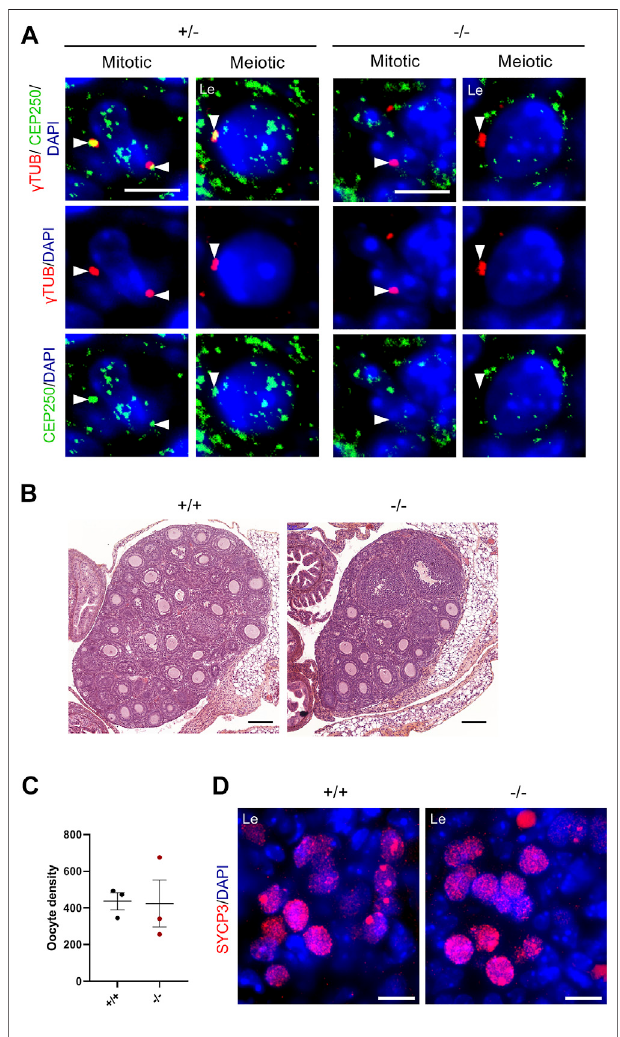
FIGURE 8 | Cep250 is not mandatory during oogenesis. (A) Immuno fl uorescence staining of γ -tubulin ( γ TUB, red) and CEP250 (green) in the control (+/ − ) and mutant ( − / − ) 15.5 days post-conception (dpc) foetal ovaries. DNA is stained with DAPI. White arrowheads indicate γ -tubulin- stained centrosomes. Note the absence of CEP250 in the centrosomes from mutant female germ cells. Le: Leptotene. Scale bar: 5 µm. (B) Hematoxylin/ eosin-stained sections of the control (+/+) and mutant ( − / − ) adult ovaries. Scale bar: 200 µm. (C) Quanti fi cation of the oocyte density in post-natal ovaries (5 – 10dpp).Mean ± SEM. (D) Immuno fl uorescence stainingofSYCP3 (red) in the control (+/ − ) and mutant ( − / − ) 15.5 days post-conception (dpc) foetal ovaries. Le: Leptotene. Scale bar: 10